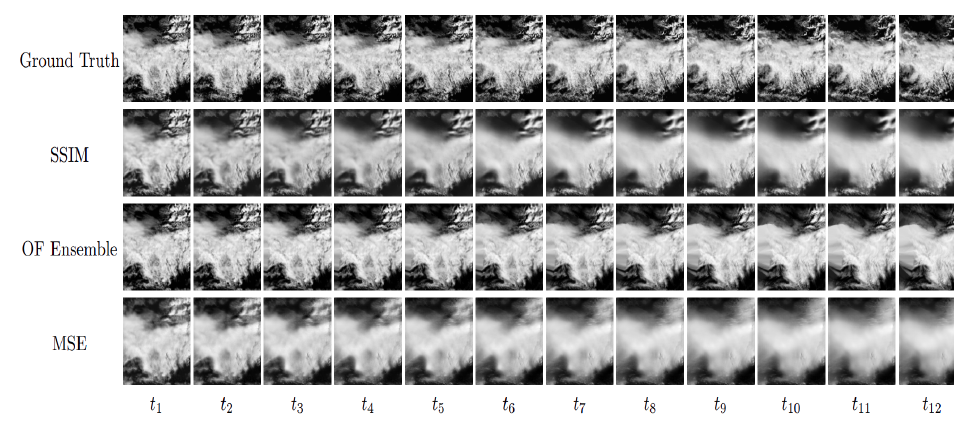
Figure A2. Example 3 h nowcasts over France on 2 May 2020.